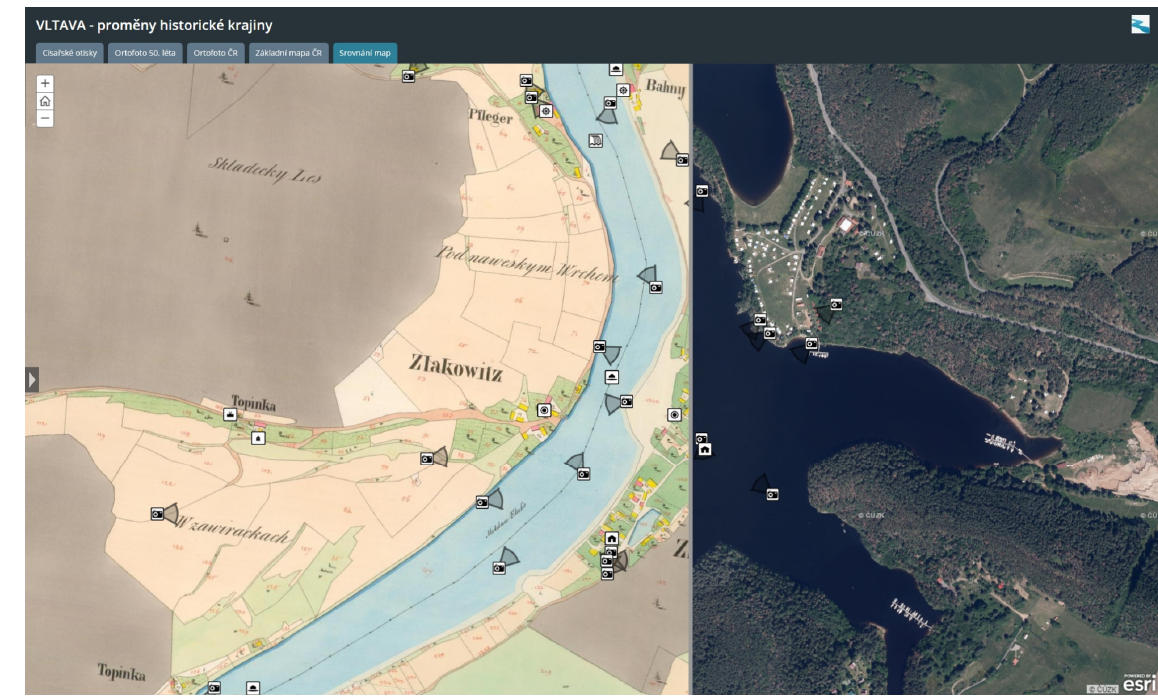
Figure 9. Map application comparing two map layers with the swipe tool, Source: author’s elabora- tion.